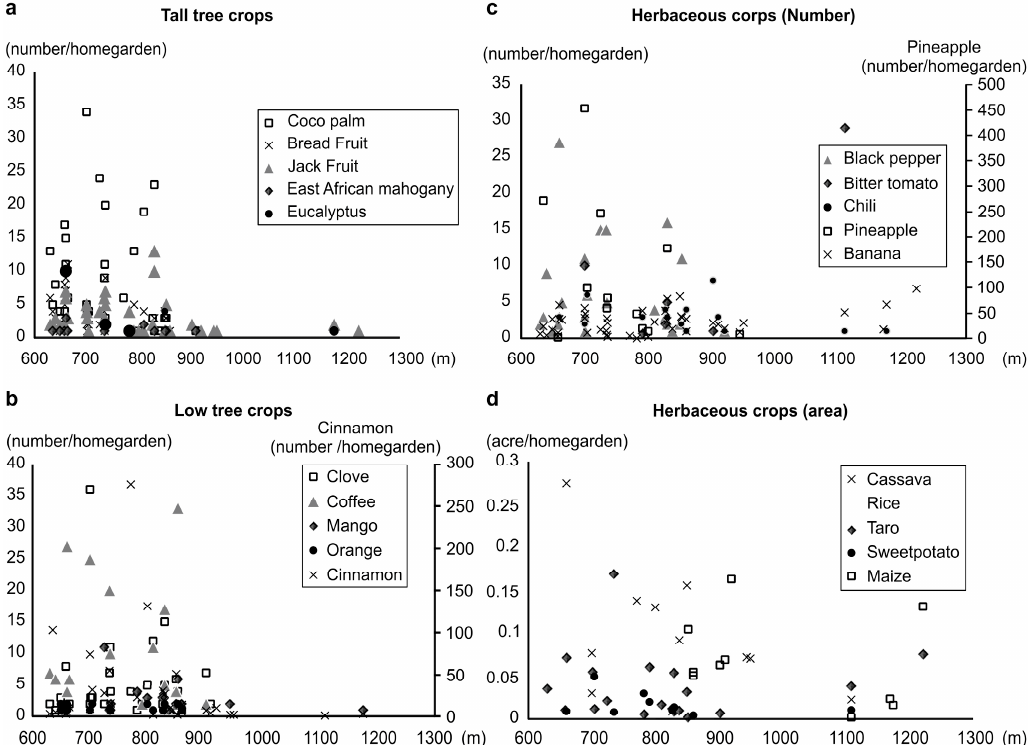
Figure 3. Relationship between altitude of homegardens and cultivated number or area occupied by each crop in each homegarden. ( a ) Tall tree crops. ( b ) Short tree crops. ( c ) Herbaceous crops (number). ( d ) Herbaceous crops (area).